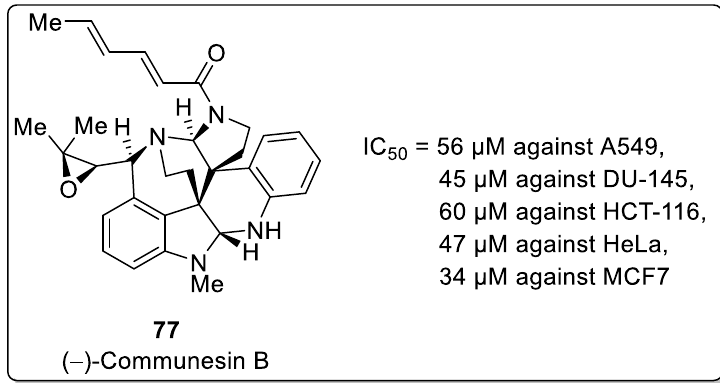
Figure 2. Anti-cancerous activities exhibited by communesin B alkaloid.